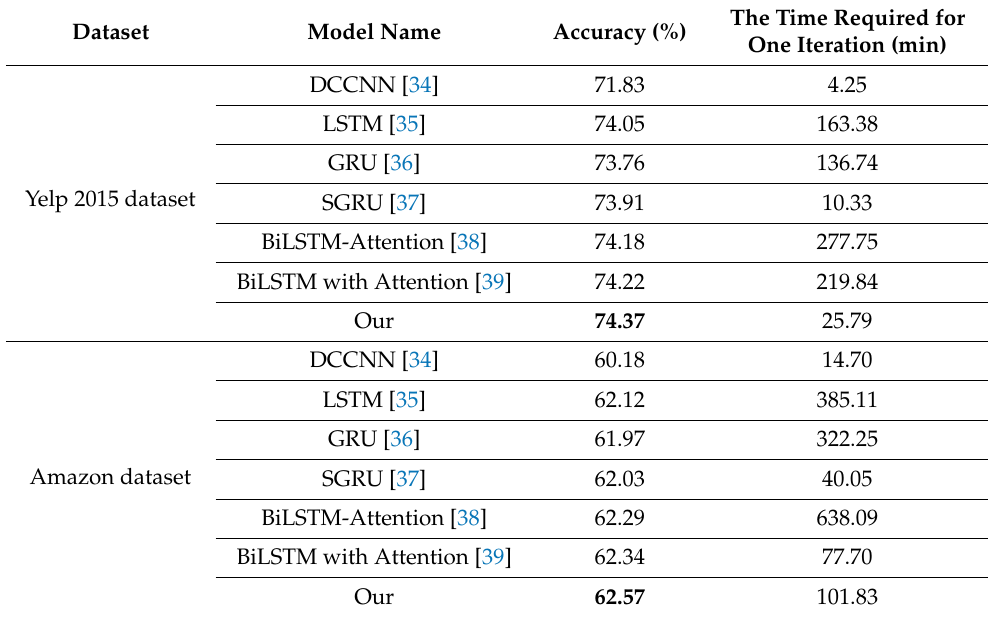
Table 4. Performance comparison of the models on two public datasets. Results that surpass all competing methods are bold .